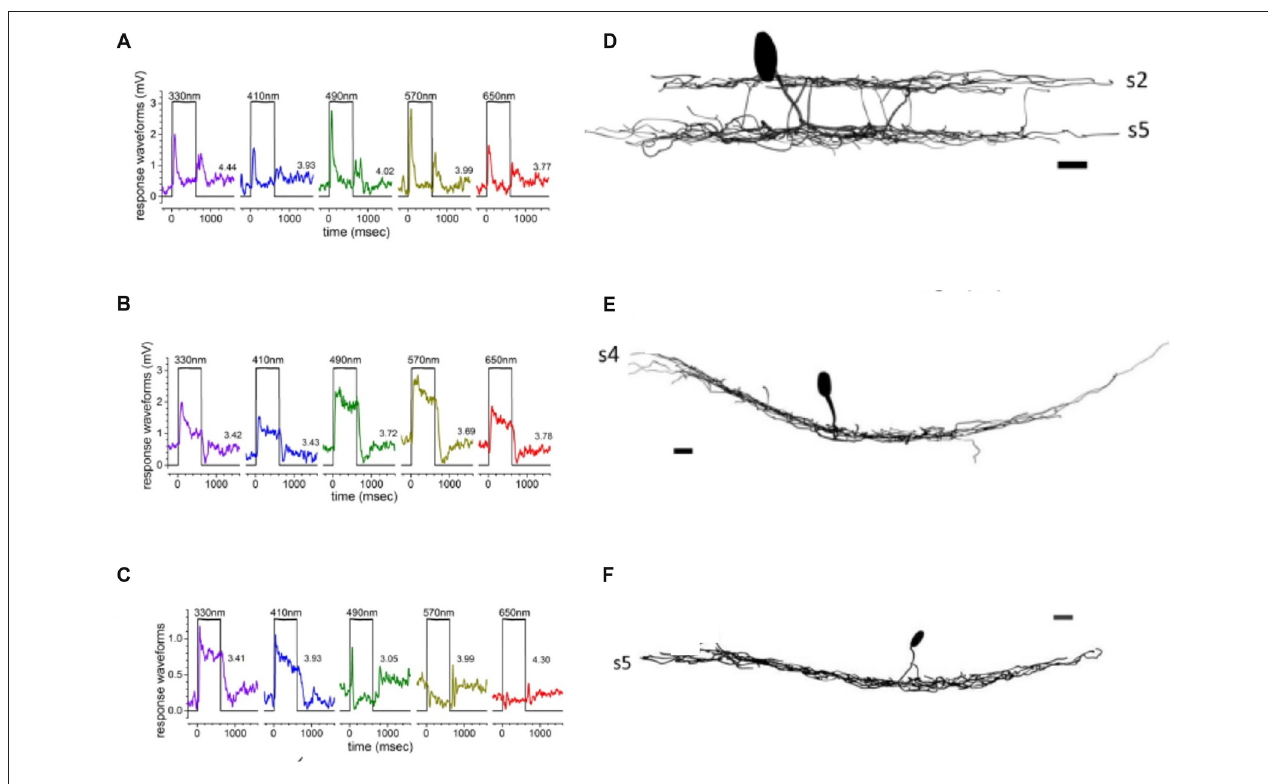
FIGURE 6 | Spectral responses of ACs are associated with specific cell types. Transient ON-OFF amacrine cells (AC) responses (A) were characteristic of bi-stratified ACs with dendrites in both the OFF- and ON-sublaminae (B) . In contrast, sustained ON responses (C) were observed in ACs with a dendritic arbor monostratified in sublamina b (D) . Spectrally multiphasic C-type responses were primarily observed in ON-cells, as shown in the biphasic response (E) from a monostratified AC with dendrites in s5 of sublamina b (F) (Torvund et al., 2017).